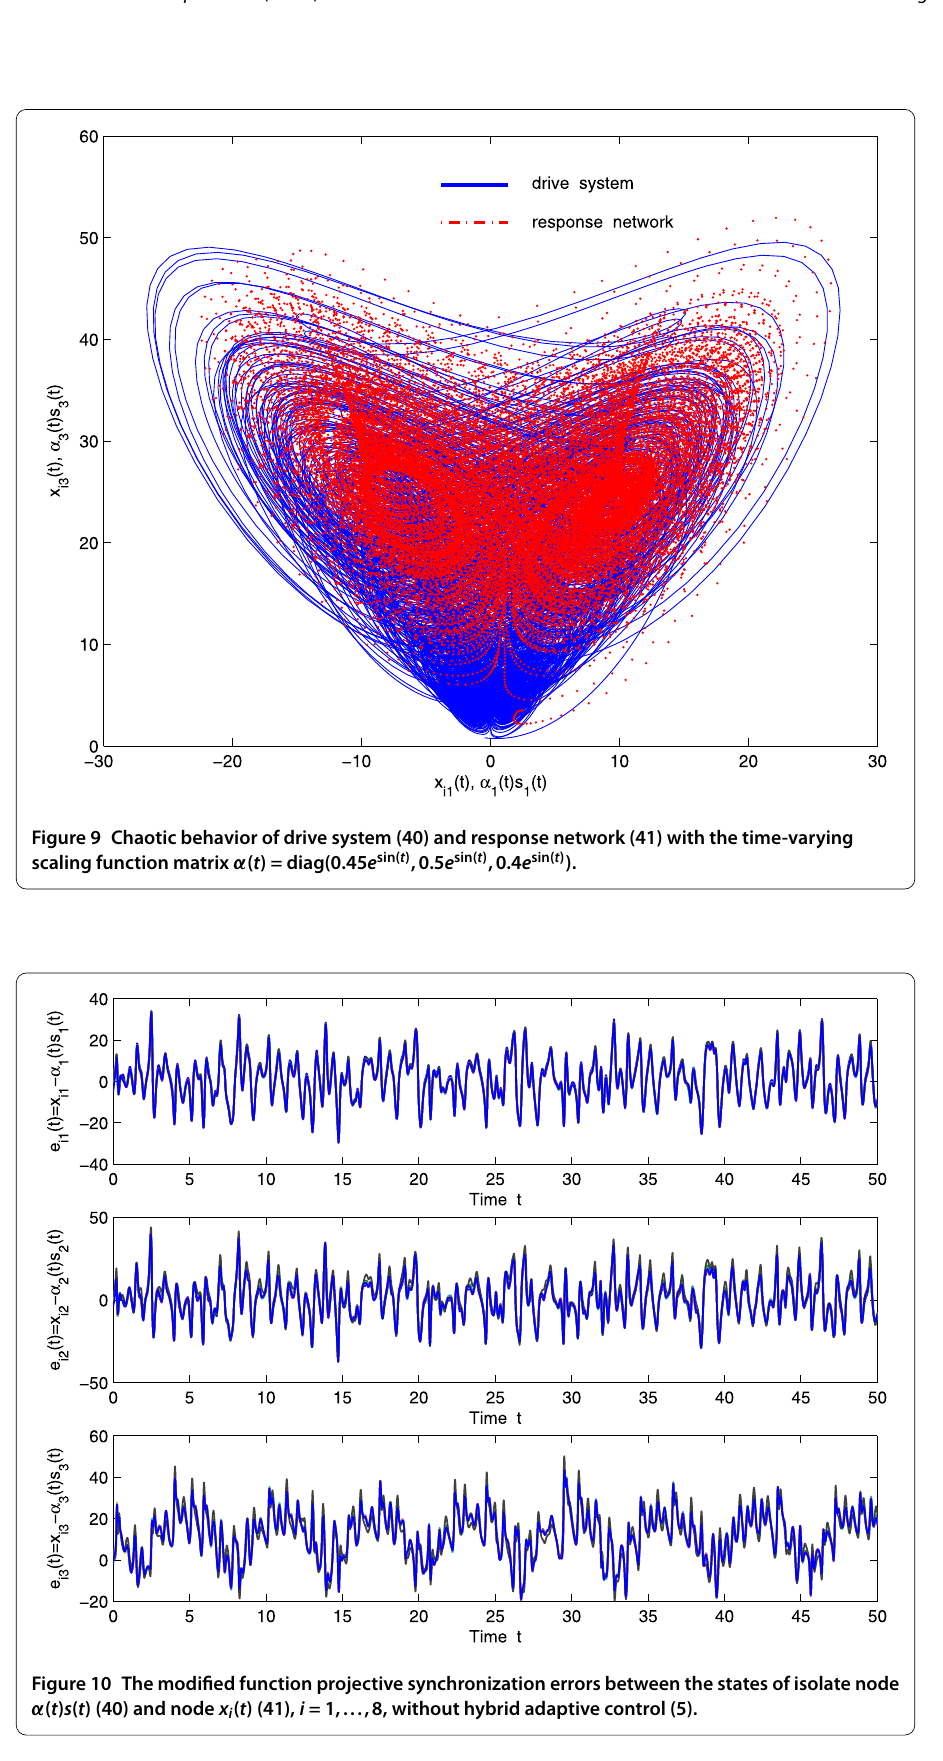
Figure 10 The modified function projective synchronization errors between the states of isolate node α ( t ) s ( t ) (40) and node x i ( t ) (41), i = 1,...,8, without hybrid adaptive control